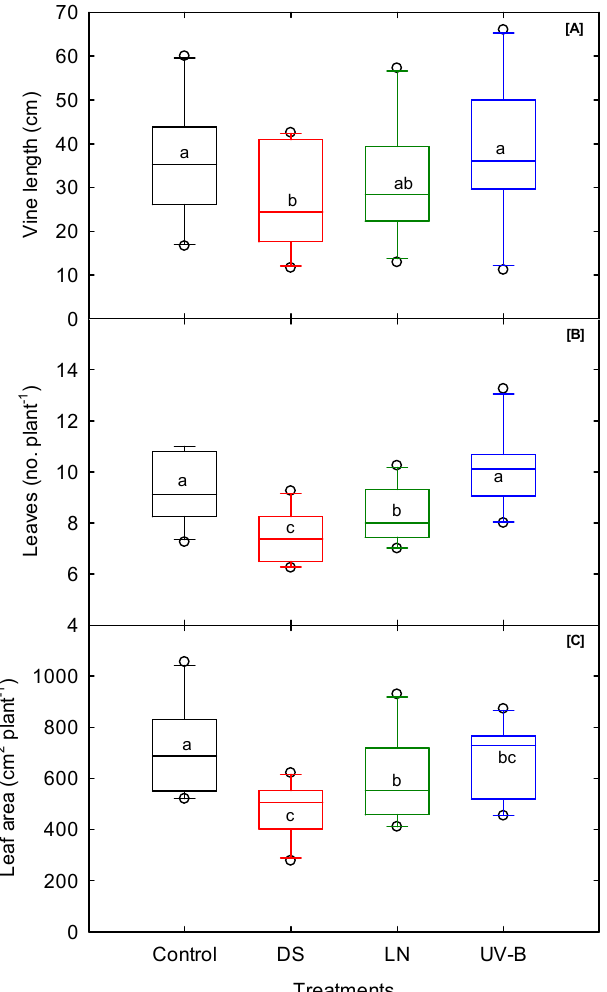
Figure 3. Drought (DS), low nitrogen (LN), and ultraviolet-B (UV-B) effect on ( A ) vine length, ( B ) leaf number, and ( C ) leaf area of 10 sweet potato cultivars measured at 20 days after planting. The middle line indicates the median, and the box shows the range of the 25th to 75th percentiles of the total data. The different alphabetic letters (a, b, and c) labeled within the box represent the significant differences between treatments (Duncan Multiple Range Test, p < 0.05), and the outer dots are outliers. Reduced vine length and leaf number in response to water deficit affected the total leaf area and, hence, the total dry weight of the plants [63]. Compared to DS and LN stress, UV-B increased the vine length and leaf number (8%). Plants exposed to DS have a reduced cell division and cell expansion rate, leading to decreased internal nodal elongation and plant height. When the root begins to sense the soil water-deficit stress, it sends a chemical signal into the shoot to minimize excessive water loss [64–66]. The overall observations implied that different cultivars exhibited differential DS, UV-B, and common nitrogen stress responses. Thus, their performance would differ according to the variations in water and nutrient availability. ‘Evangeline’ produced the longest vine and highest leaf number under DS and UV-B treatments. In contrast, under LN stress, ‘Beauregard B-14’, ‘Beauregard B-63’, ‘NC05-198’, and ‘Vardaman’ produced the shortest vine lengths and lowest leaf numbers across treatments (Table S2). The cultivars ‘Bonita’ under DS and LN and ‘Orleans’ under UV-B stress exhibited the highest shoot dry weight. The cultivars ‘Covington’ under DS, ‘Beauregard B-14’ under UV-B, and ‘Evangeline’ under LN stress were found to produce the lowest shoot dry